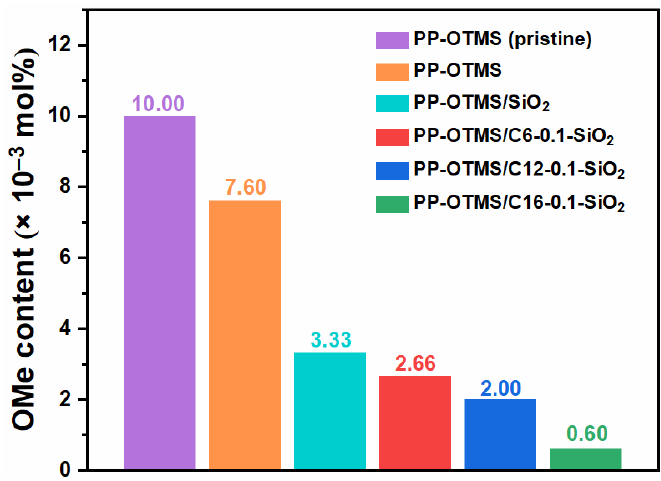
Figure 2. TEM images of nanocomposites: ( a ) HomoPP/SiO 2 , ( b ) PP-OTMS/SiO 2 , ( c ) PP-OTMS/C6- 0.1-SiO 2 , ( d ) PP-OTMS/C12-0.1-SiO 2 , and ( e ) PP-OTMS/C16-0.1-SiO 2 . The SiO 2 content was 5.0 wt% for all the samples. ( f ) The dispersion parameter ( D ) acquired from TEM images.